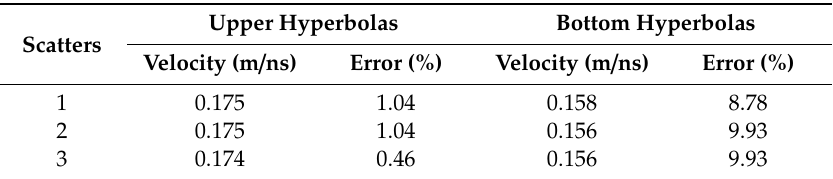
Figure 2. Velocity spectrum contour slices of three hyperbolas. The black crossed lines indicate the positions of maximum value. Table 1. The estimated results and errors of model test.